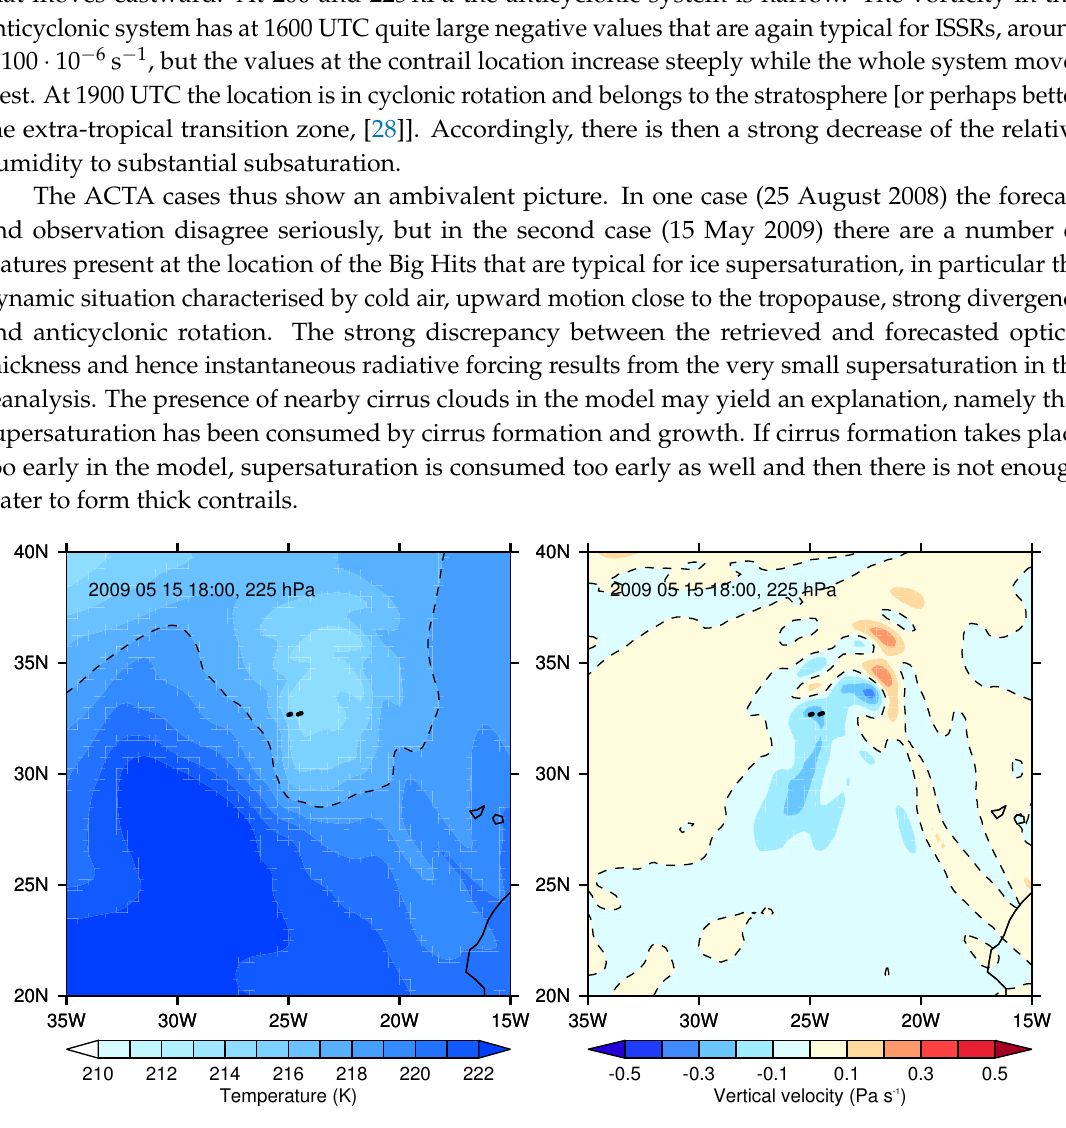
Figure 7. ( Left ): Temperature field for the situation of Figure 5. The black line marks a temperature of − 65 ◦ C. ( Right ): Field of vertical velocity in pressure coordinates. Blue is upward, red